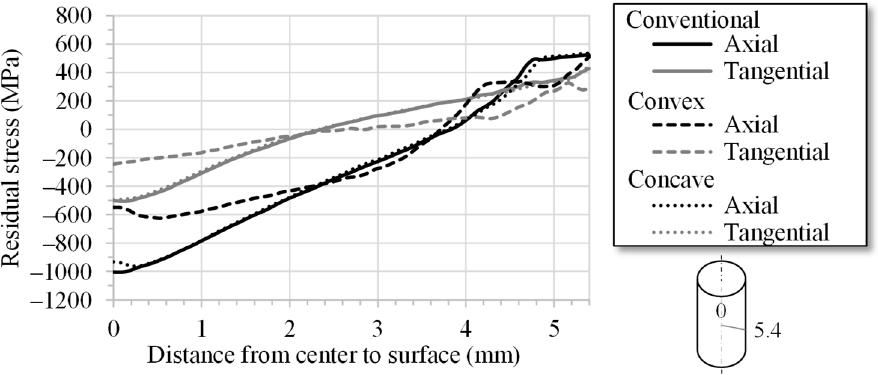
Figure 8. FE simulation of wire-drawing—axial and tangential residual stresses over the specimen cross-section as a function of the geometric elements.